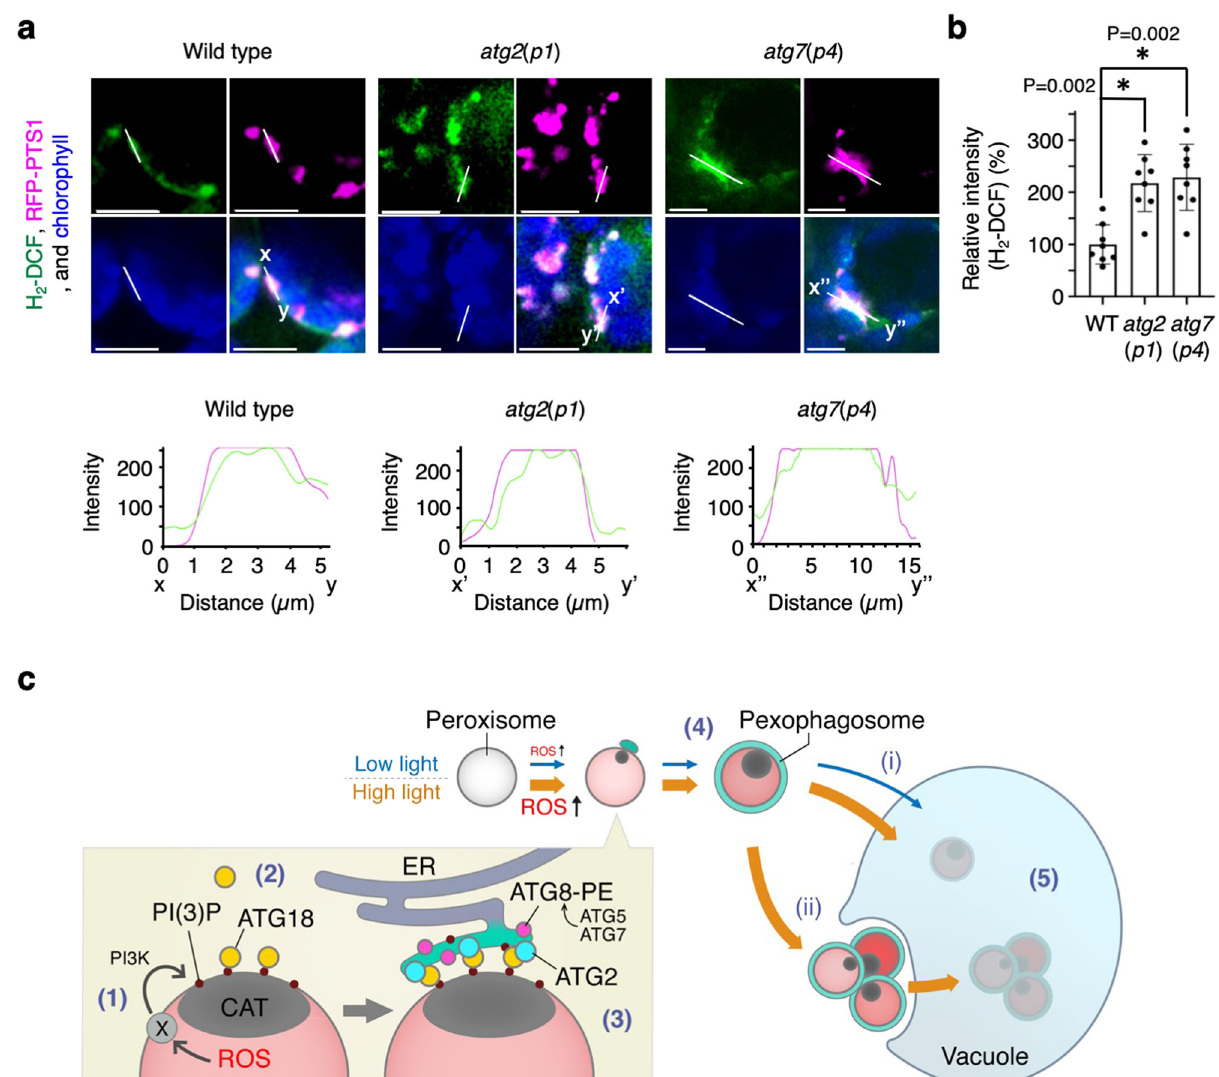
Fig. 7 | ROS accumulation in peroxisomes and a model of pexophagy under high-intensitylightconditions.a DetectionofROSusingH 2 -DCFstaining(green) after exposure to high-intensity light of WT, atg2 ( p1 ), and atg7 ( p4 ) plants. Green, magenta and blue indicate H 2 -DCF, peroxisomes (RFP-PTS1), and chloroplasts (auto fl uorescence), respectively. Plants were grown and adapted to high-intensity light similar to thatshown in Figs. 4, 5. Plot pro fi le of fl uorescence intensity on the lines; x – y (WT), x ’– y ’ ( atg2 ( p1 )),and x ”– y ” ( atg7 ( p4 ))depicted in each upper image. Scale bars, 10 µ m. b Relative fl uorescence intensity of H 2 -DCF in peroxisome aggregatesinWT, atg2 ( p1 ),and atg7 ( p4 ).Atotalof140peroxisomesfromeachline were tested. The error bars indicate mean±standard deviation ( n =8 biologically independent replicates), and asterisks indicate signi fi cant differences between WT and atg2 ( p1 ) or atg7 ( p4 ) (* P <0.01, two-sided Student ’ s t -test). The representative